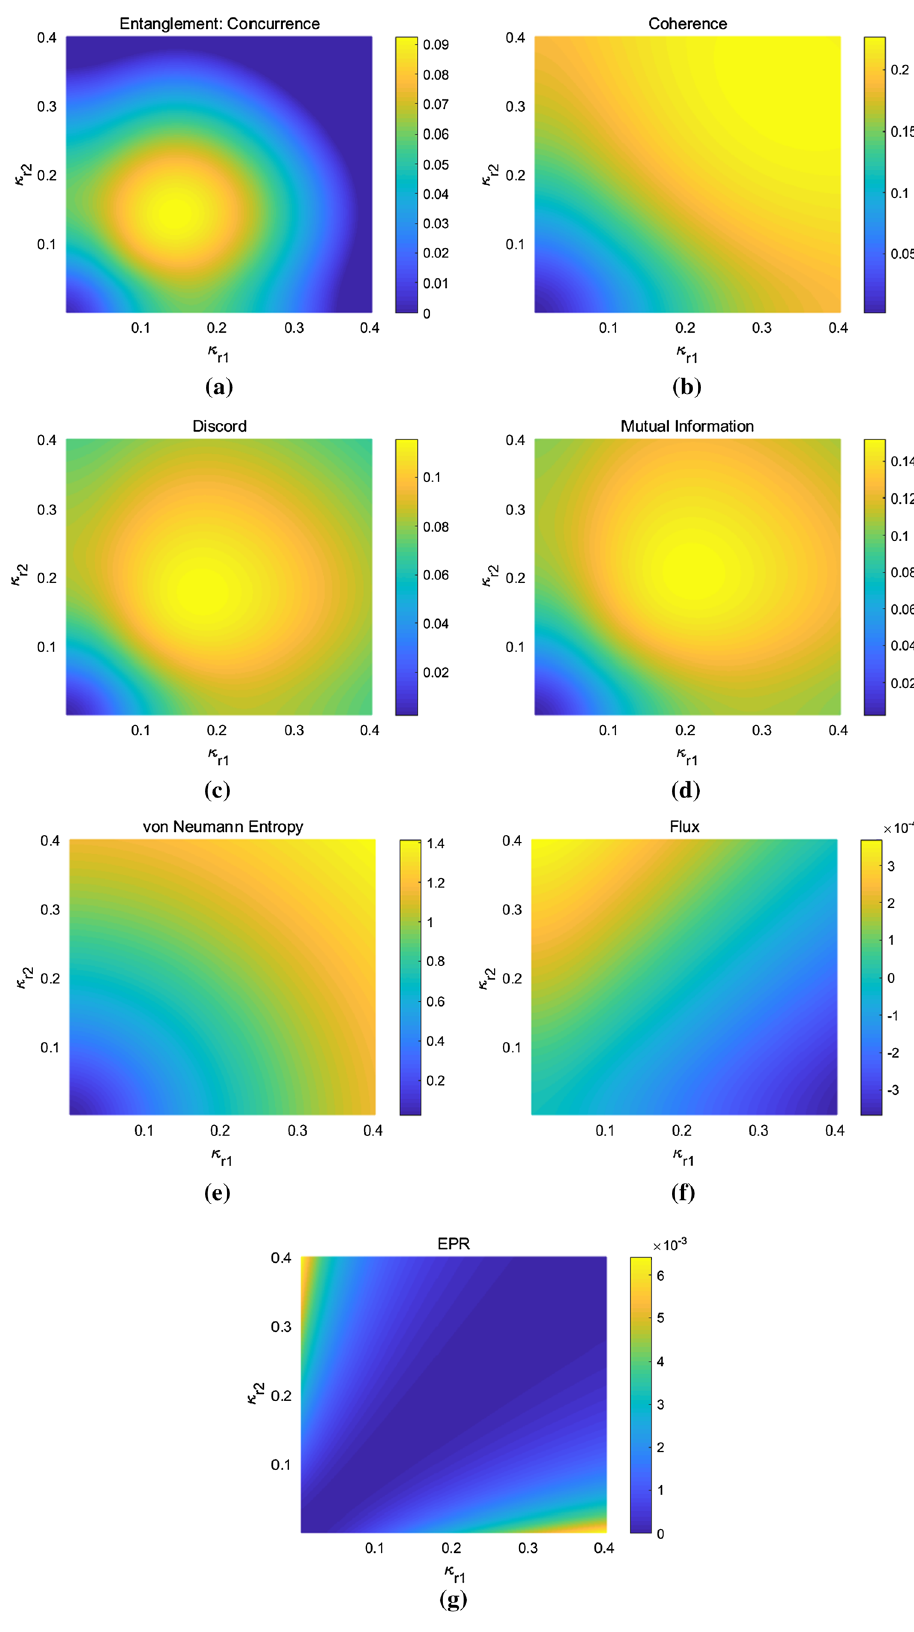
Fig. 15 Quantum correlations at nonequilibrium steady state vary with κ r 1 and κ r